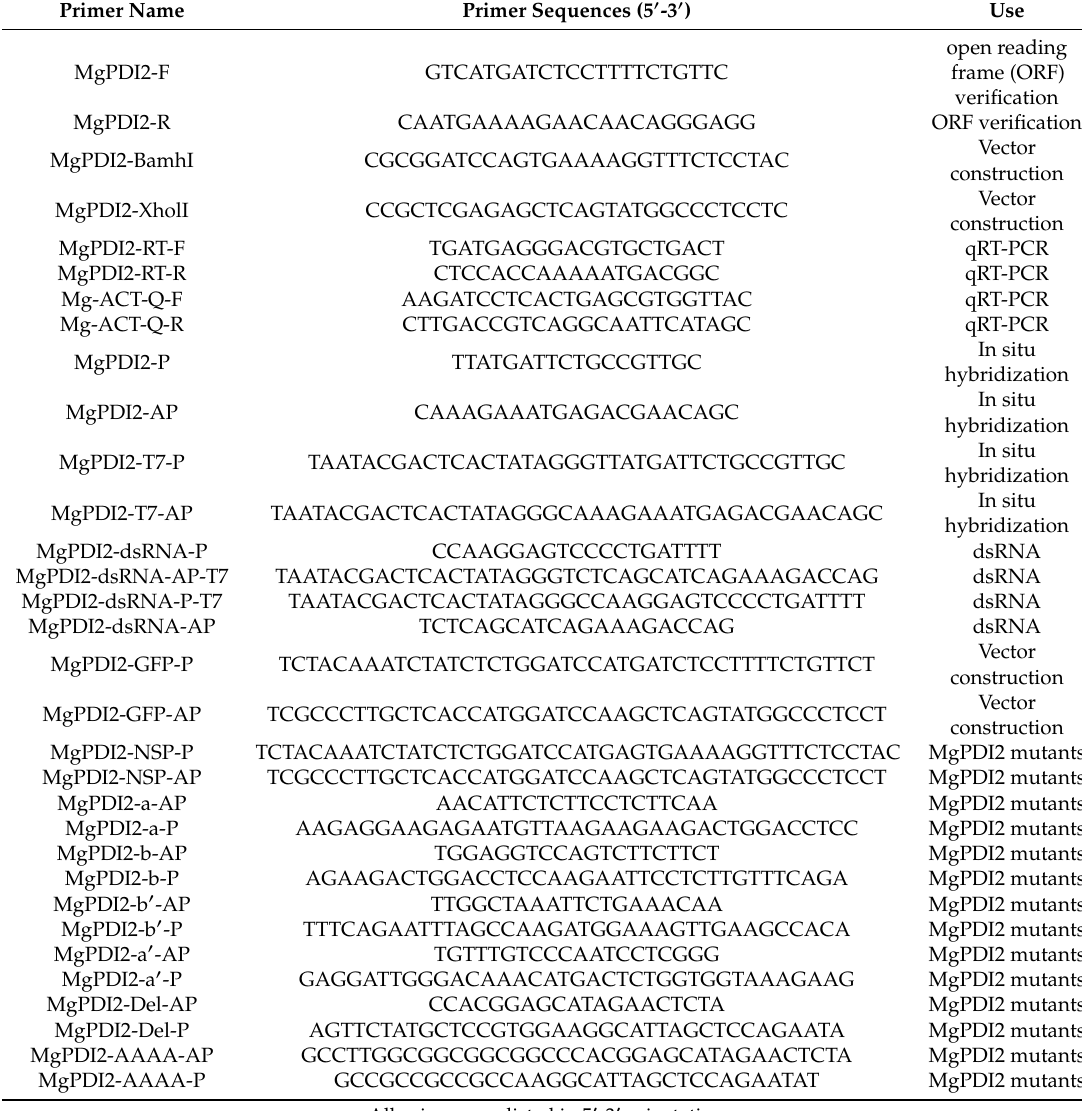
Table 2. Primer sequences used in this